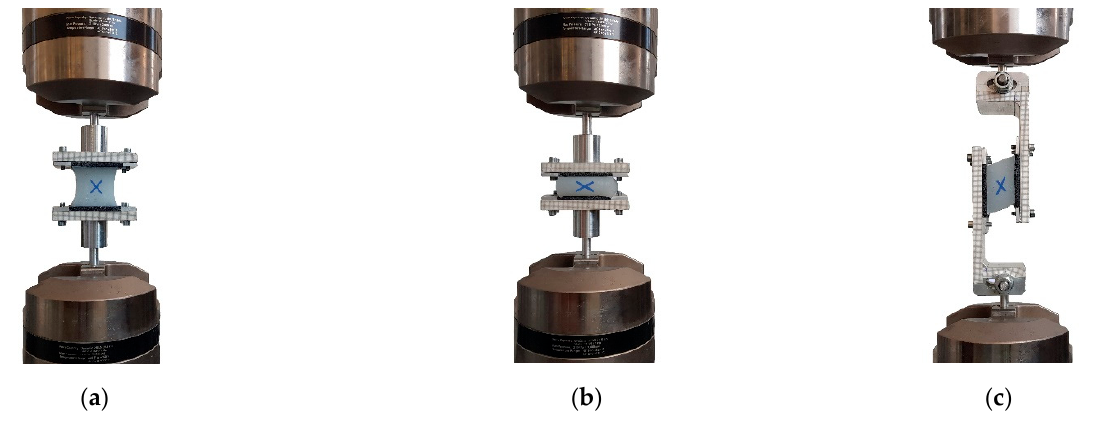
Figure A1. Specimen during the characterization test. ( a ) Tension. ( b ) Compression. ( c ) Shear. Data were analyzed with the software MATLAB R2020b (MathWorks). First, data were low pass filtered using a Butterworth zero-phase filter with cut-off frequency of 2 Hz and averaged among the sine cycles to obtain a mean load cycle. Displacement and force data were normalized with respect to the height and the area of the specimen to compute the nominal strain and stress, respectively. The averaged cycles for the three tested conditions are shown in Figure A2.